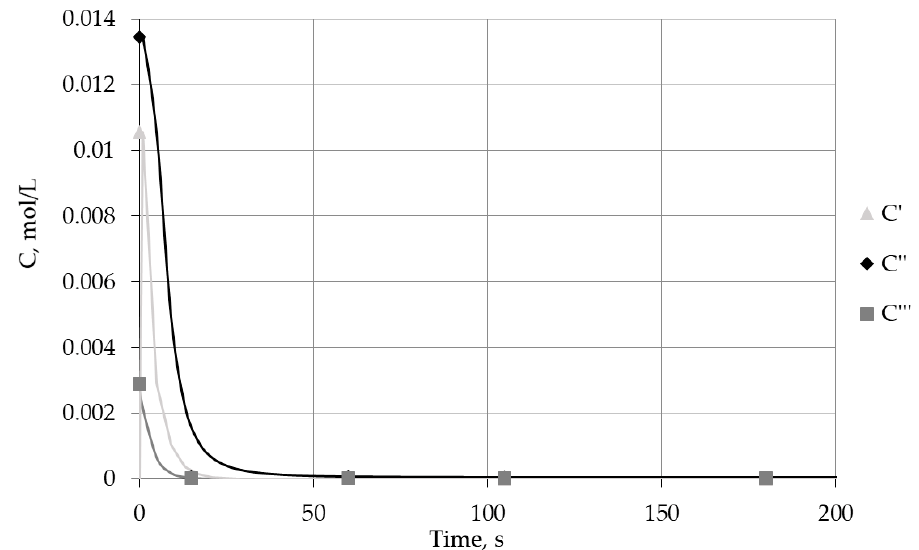
Figure 5. Kinetic dependencies of H 2 S concentration change on sorption time at different initial concentrations and T = 298 K.